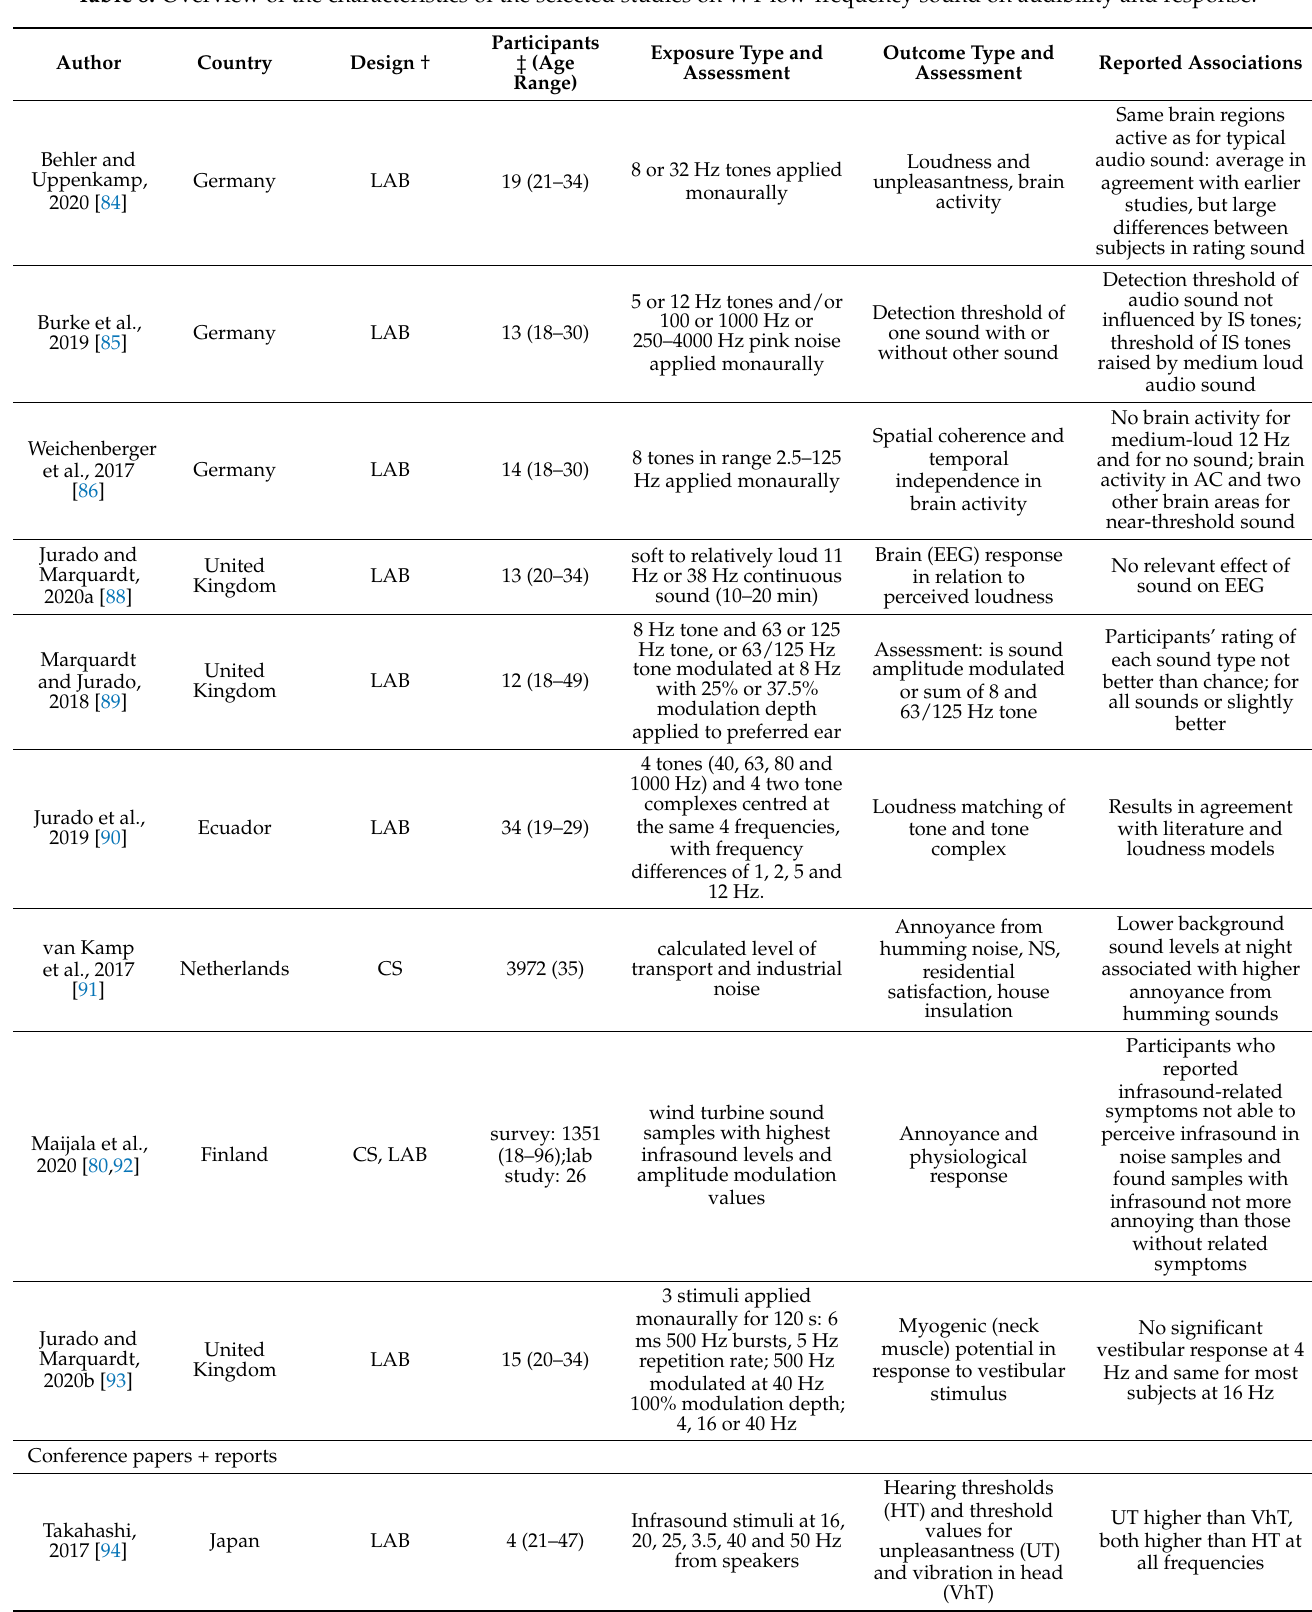
Table 8. Overview of the characteristics of the selected studies on WT low-frequency sound on audibility and